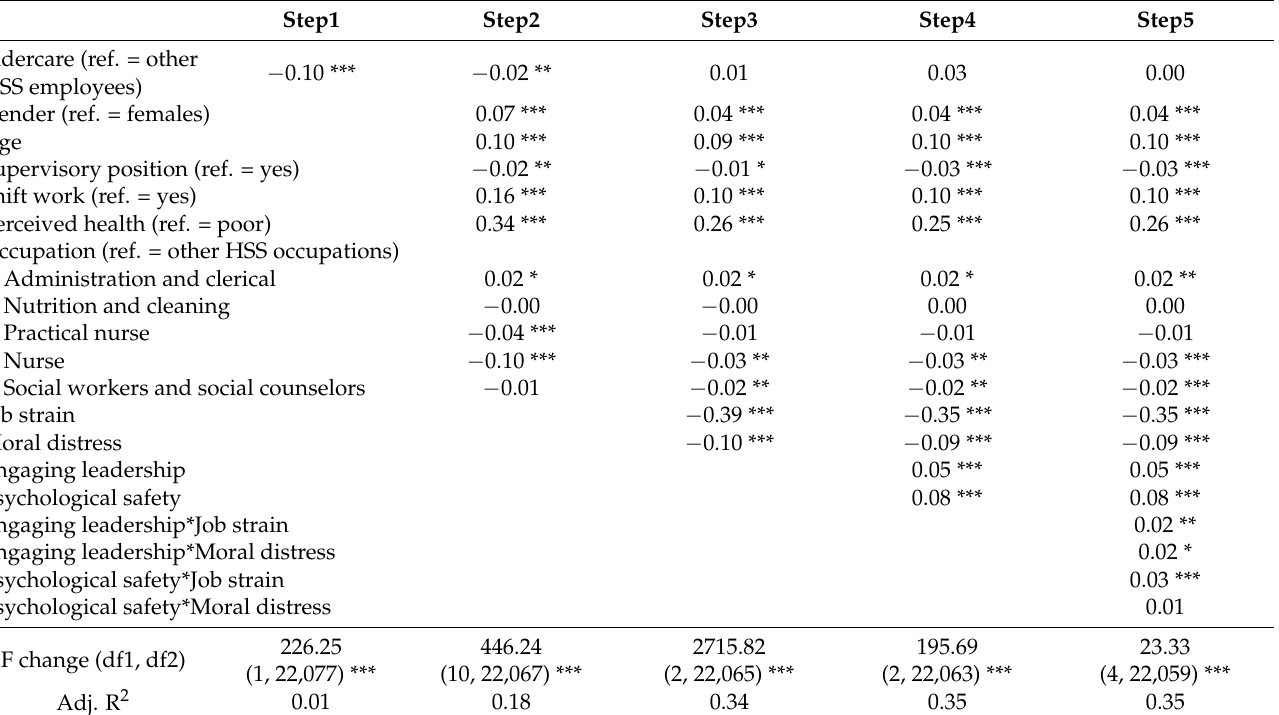
Table 2. Associations between recovery from work, job demands, and job resources based on linear regression analysis. Standardized regression coefficients and their statistical significance are